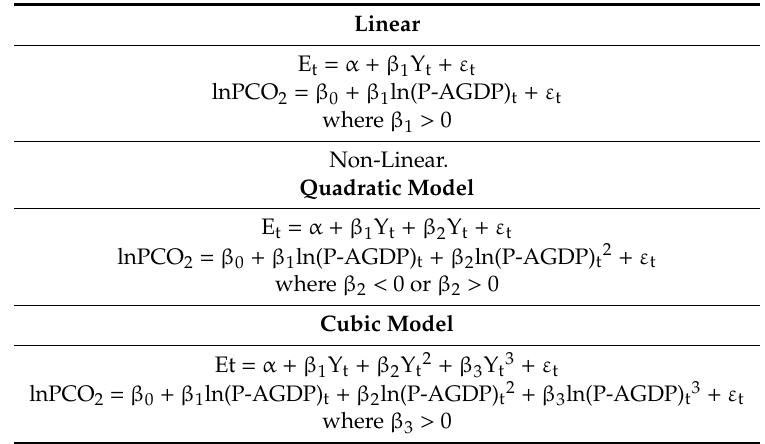
Table 3. Regression models analyzed in the